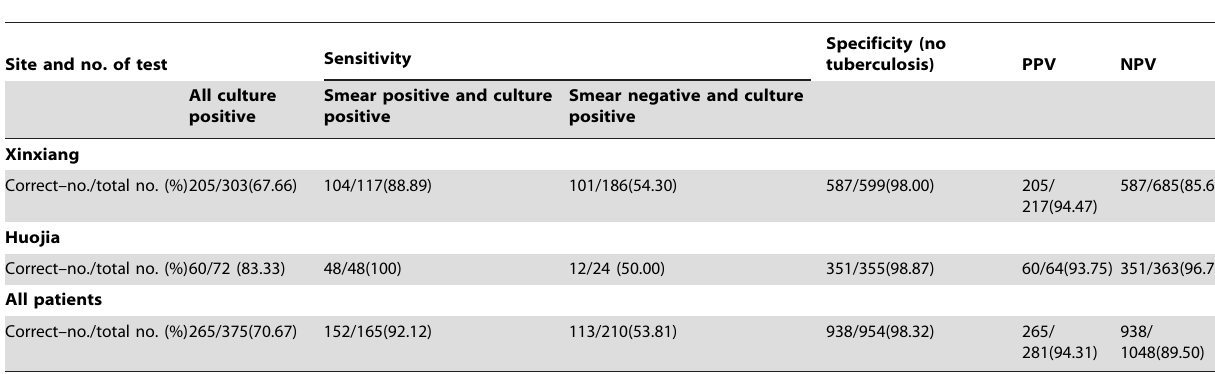
Table 2. Performance of the PURE-LAMP test for TB detection in TB suspects based on spot sputum.